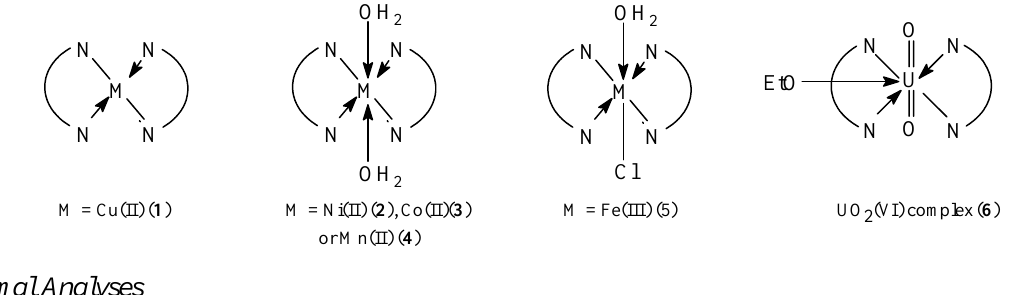
Figure 2. Suggested structures of the metal complexes of the HL ligand.